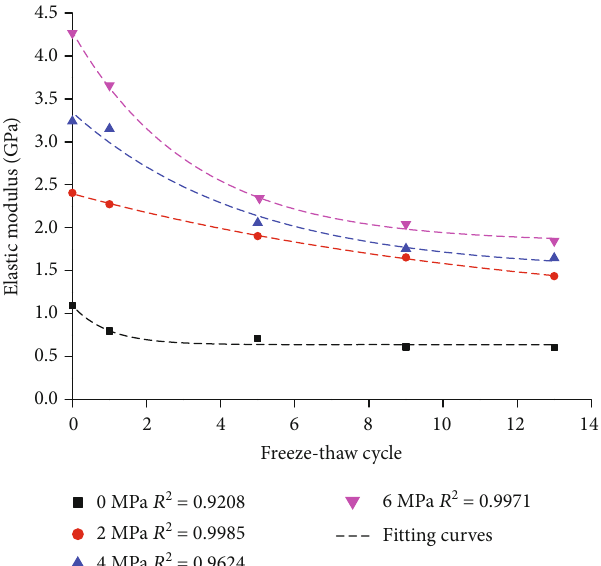
Figure 8: Curves of the triaxial compressive strength of the tested red sandstone versus the number of freeze-thaw cycles under di ff erent con fi ning pressures.